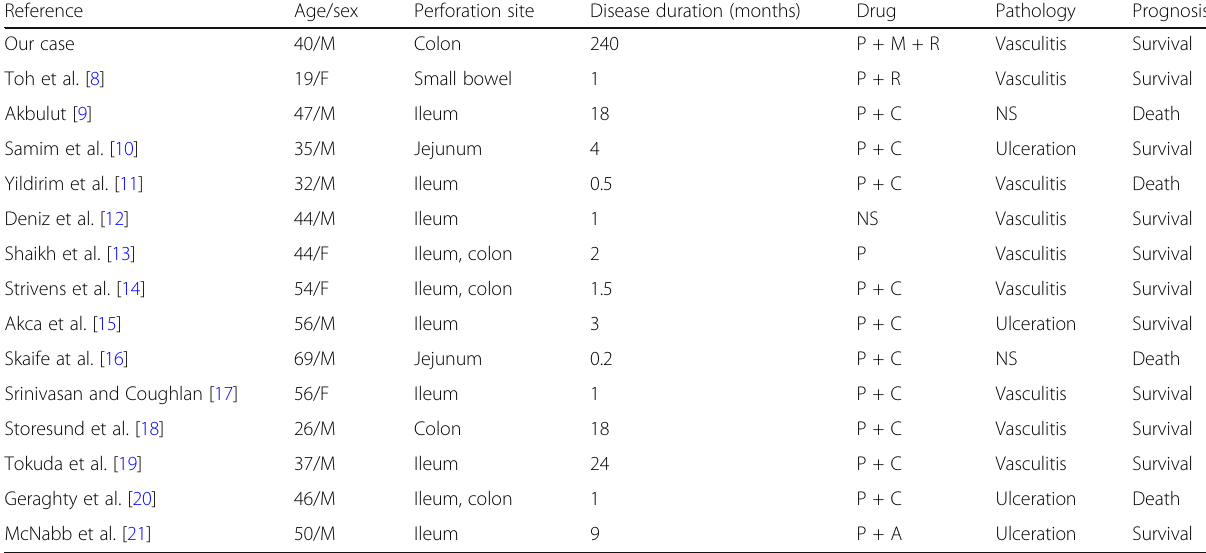
Table 1 Reported cases of intestinal perforation associated with granulomatosis with polyangiitis Reference Age/sex Perforation site Disease duration (months) Drug Pathology